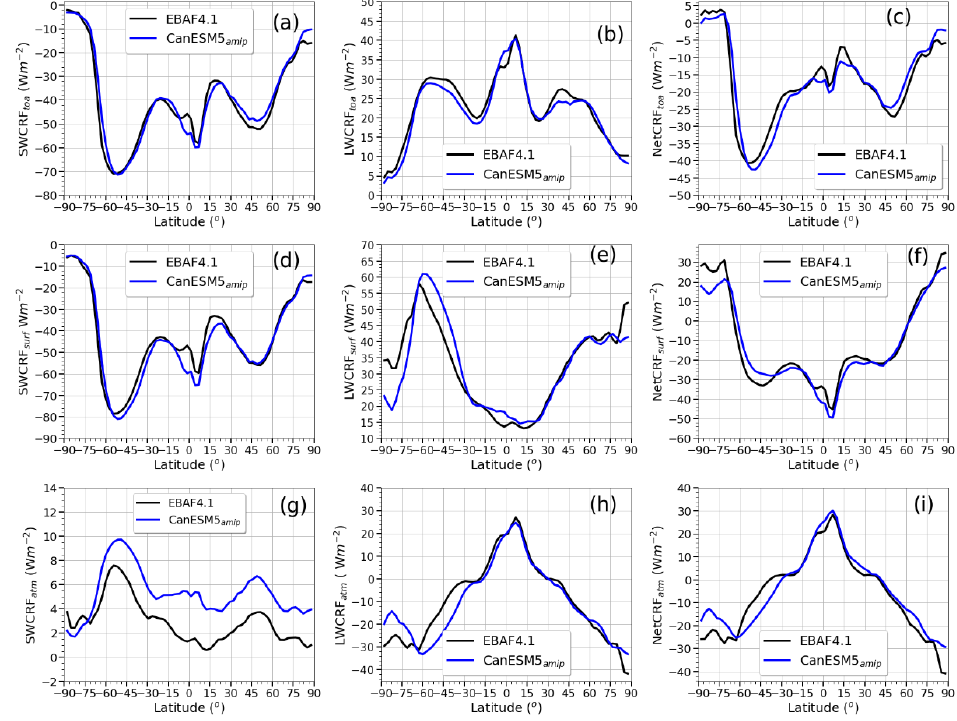
Figure 15. Zonally and annually averaged SWCRF, LWCRF, and NetCRF TOA ( a – c ), at the surface ( d – f ) and atmosphere ( g – i ).